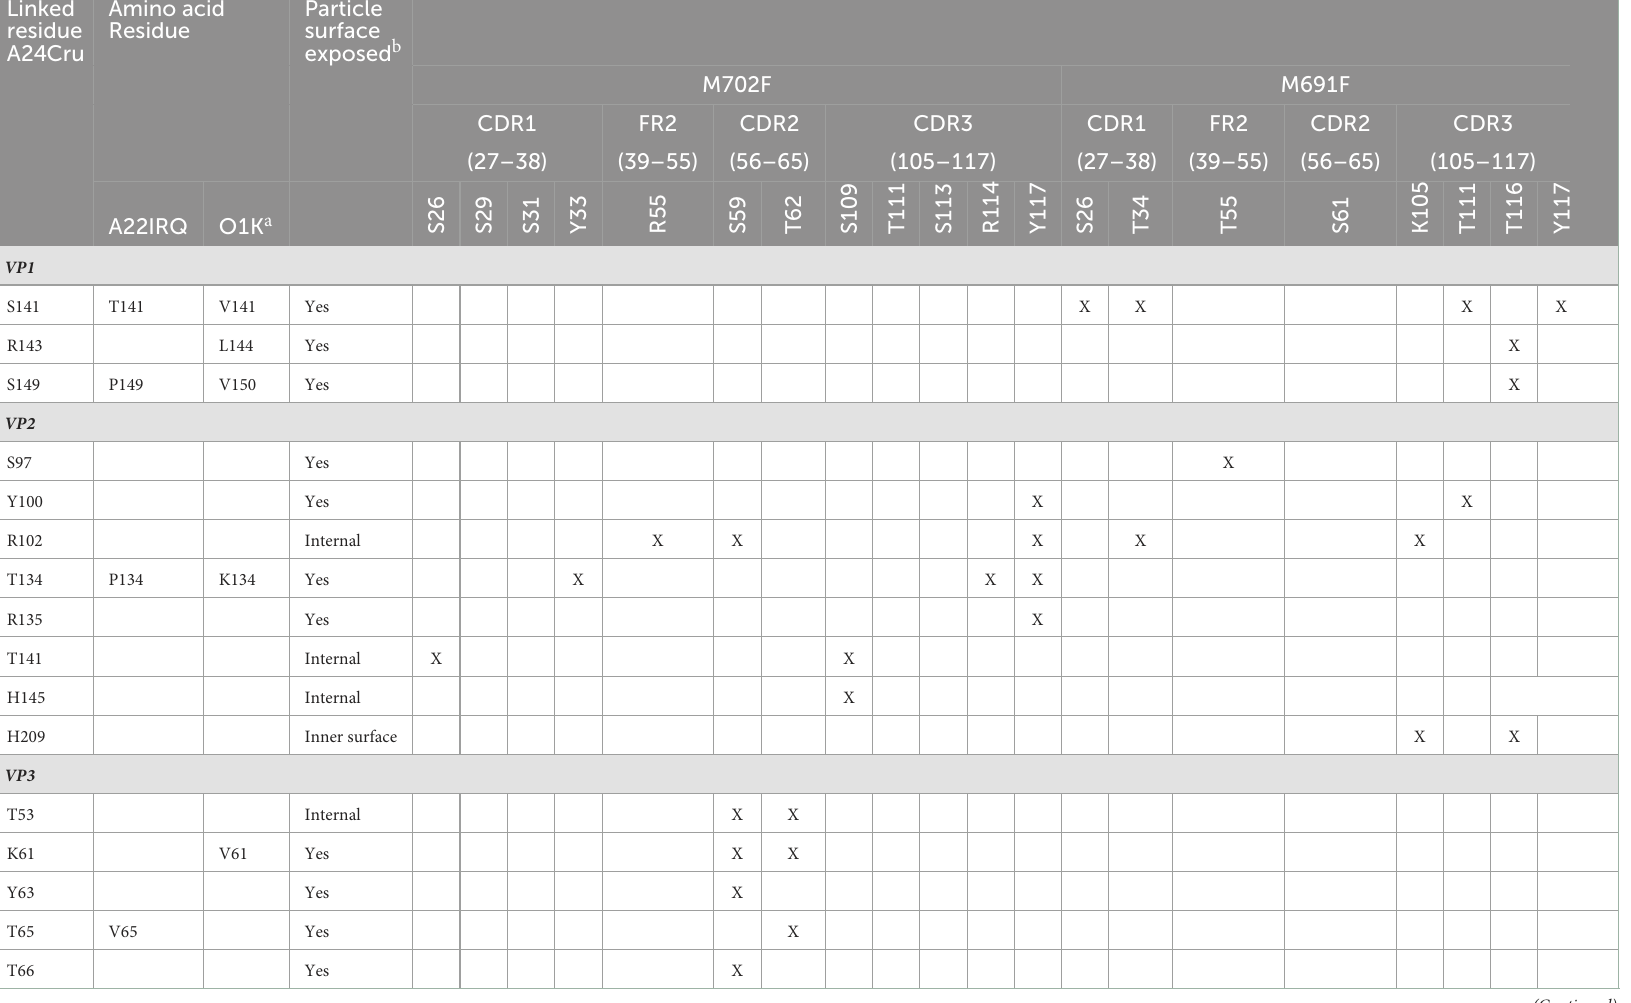
TABLE 3 Cross-linked amino acid residues (X) of FMDV A24Cru 146S particles complexed with M702F or M691F VHHs identified by XL-MS analysis. Cross-